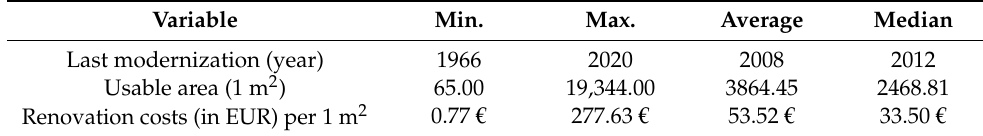
Table 3. The statistical calculations for the dependent and the independent variables. Variable Min. Max.